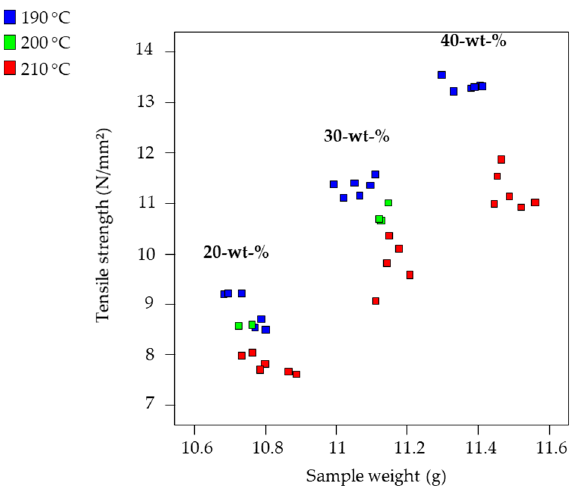
Figure 4. Correlation of tensile strength and specimen weight of wood ‐ filled TPU.